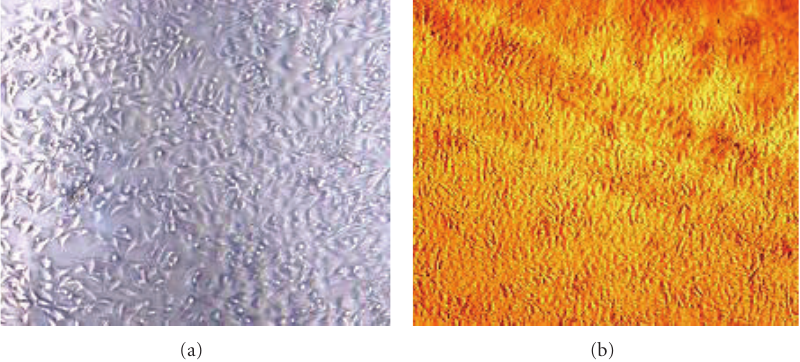
Figure 6: Fibroblast cells growth on the hydrogel sample (100 × ): (a) After 24 hours; (b) After 48